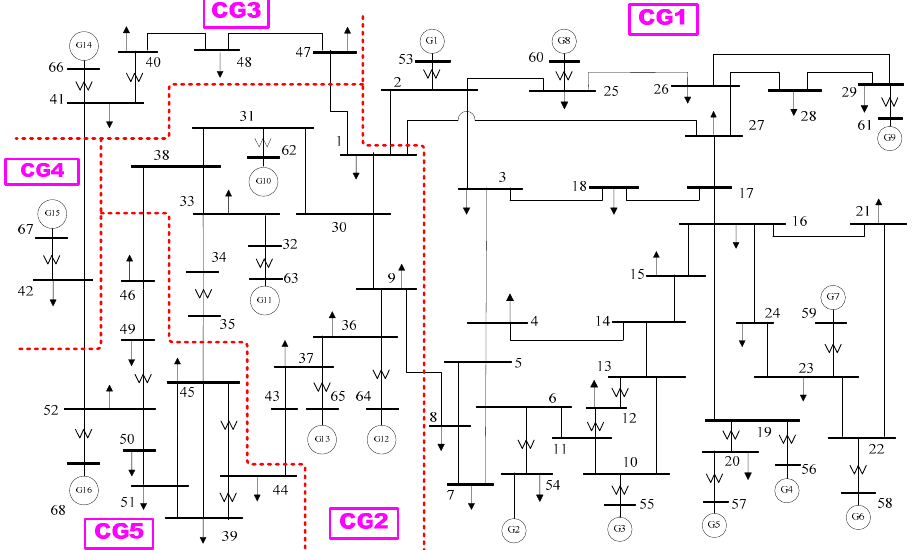
Figure 6. The splitting strategies for the NETS–NYPS interconnected power system.